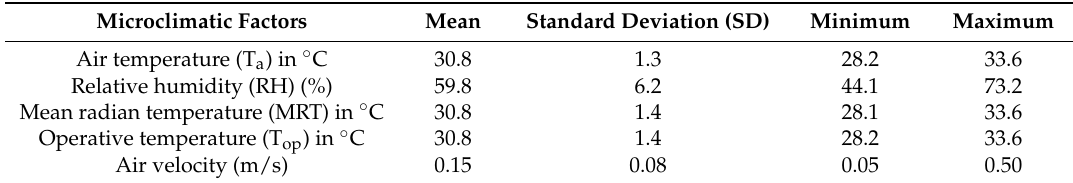
Table 6. Thermal conditions of the surveyed classrooms.